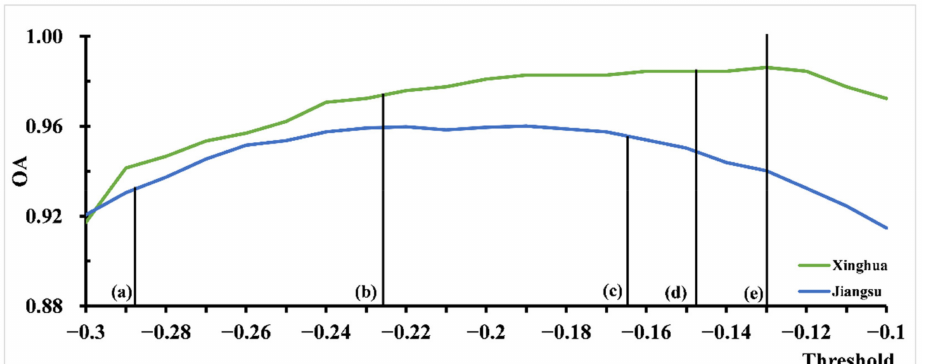
Figure 7. Empirical threshold in Xinghua County and Jiangsu Province. The green and blue curves are overall accuracy (OA) values at every empirical threshold in Xinghua and Jiangsu, respectively. Panel ( a ) is the threshold selected using Otsu method in Jiangsu Province; panel ( b ) is the threshold selected using Otsu method in Xinghua County; panel ( c ) is the threshold selected using Otsu with Canny Edge Detection (OCED) method in Jiangsu Province; panel ( d ) is the threshold selected using OCED method in Xinghua County; and panel ( e ) is the empirical threshold value determined in Xinghua while applied in